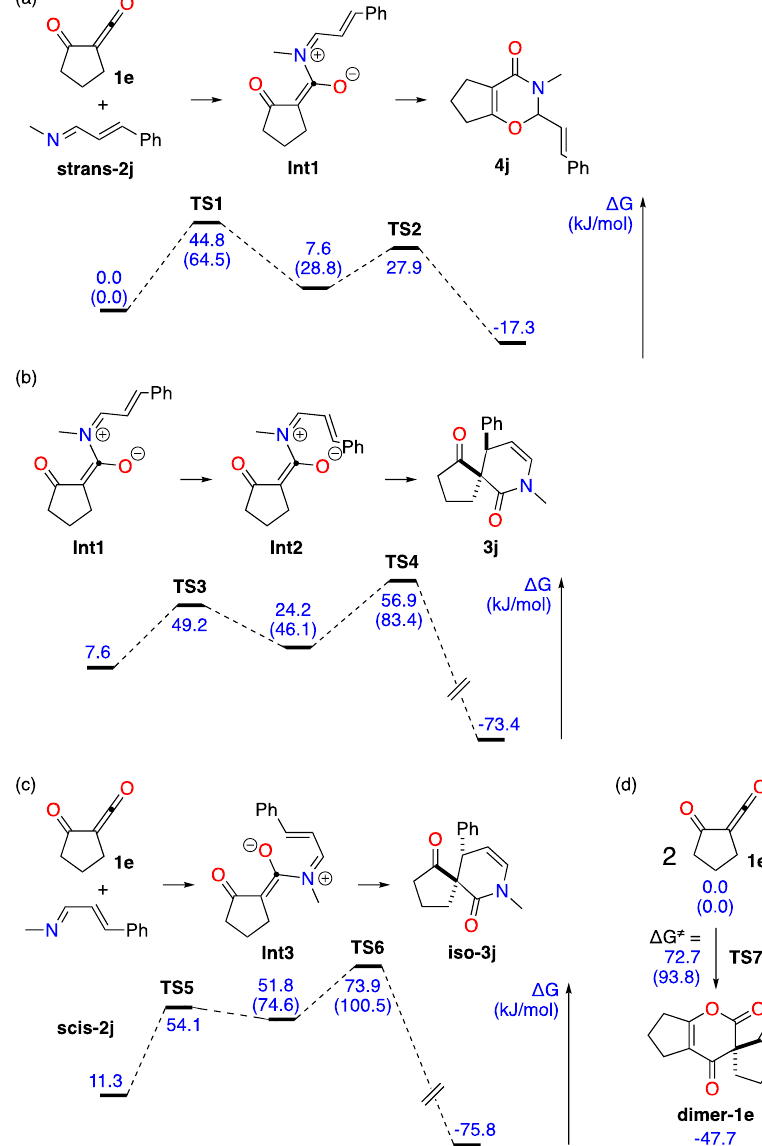
Figure 1. Free Gibbs energy profiles computed at 298 K (DFT, B3LYP-D3/6-311++G(d,p)) of the aza-Diels−Alder reactions between the α-oxoketene 1e and the 1-azadiene 2j , and cyclodimerization of α-oxoketene 1e . Free Gibbs energies noted between parentheses were computed at 413 K.